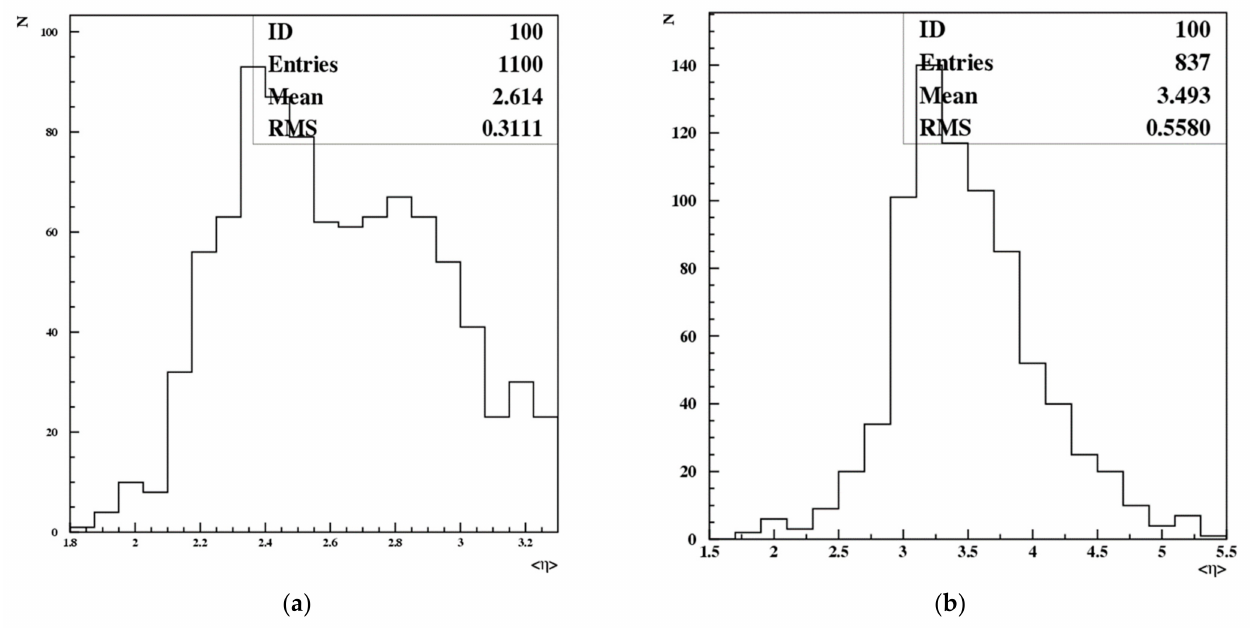
Figure 3. The distribution of the average pseudo-rapidity in event of ( a ) Au + Em 10.6 AGeV and ( b ) Si + Em 14.6